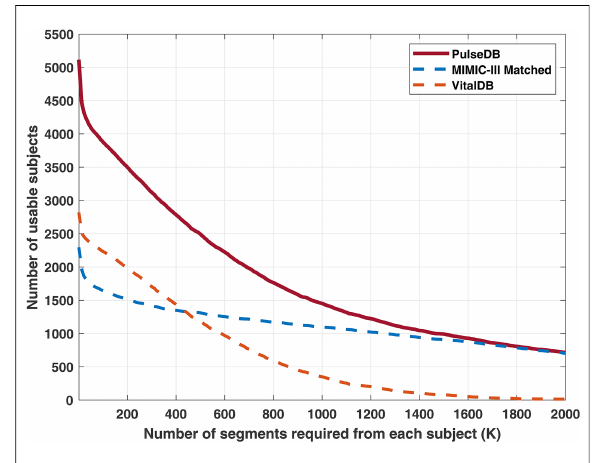
FIGURE 2 Red solid line: number of usable subjects in the PulseDB dataset when requiring each subject to have at least K segments. Blue and orange dashed lines: number of usable subjects from the MIMIC- III matched subset and the VitalDB database, for each selected K . The subjects used for generating the AAMI testing set were removed and not included here.